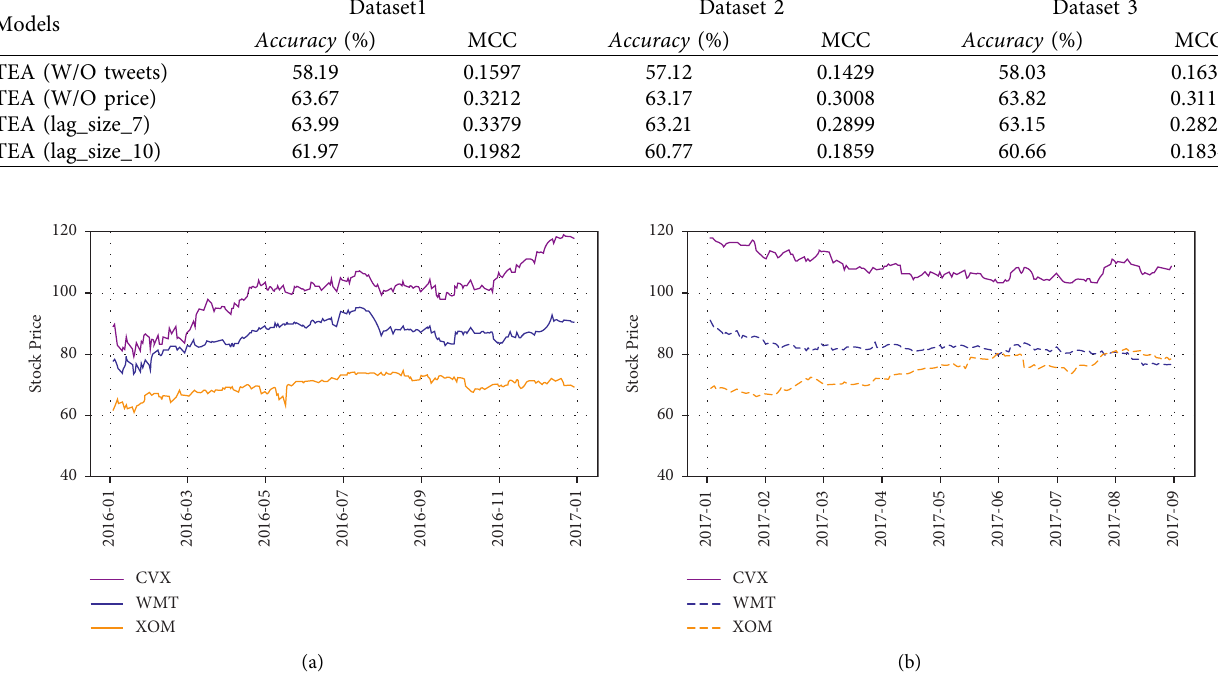
Figure 4: Demonstration of temporal